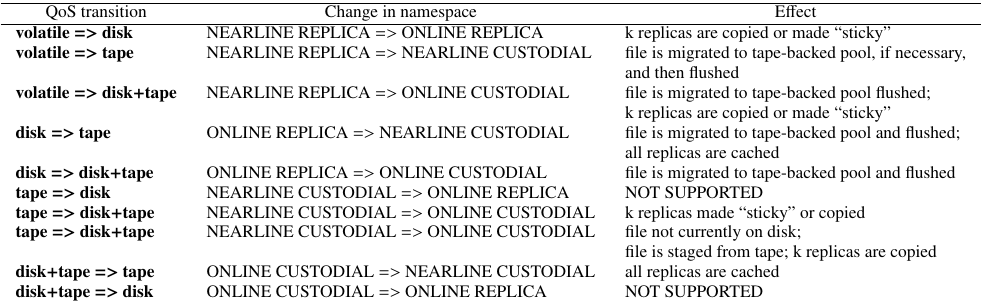
Table 2. Prototype QoS Transitions and How They Are